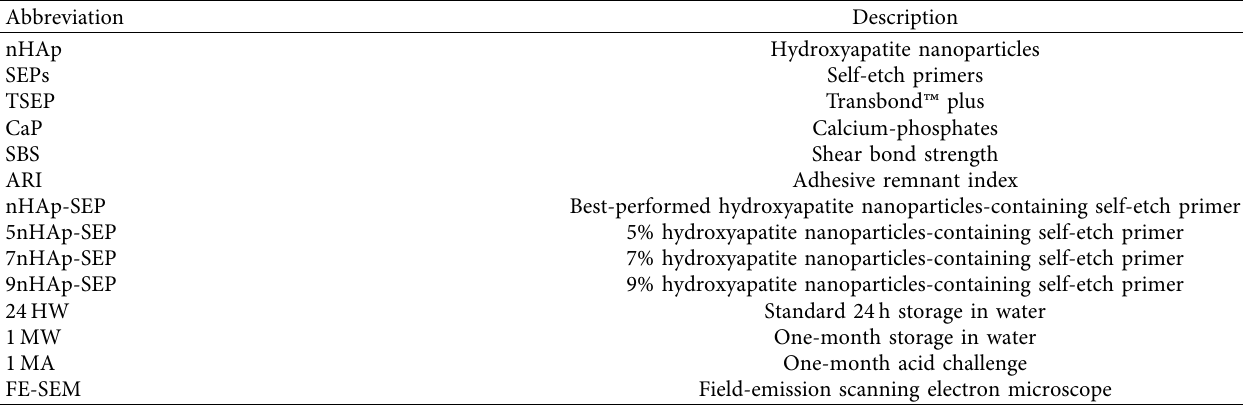
Table 1: List of abbreviations used in this study.